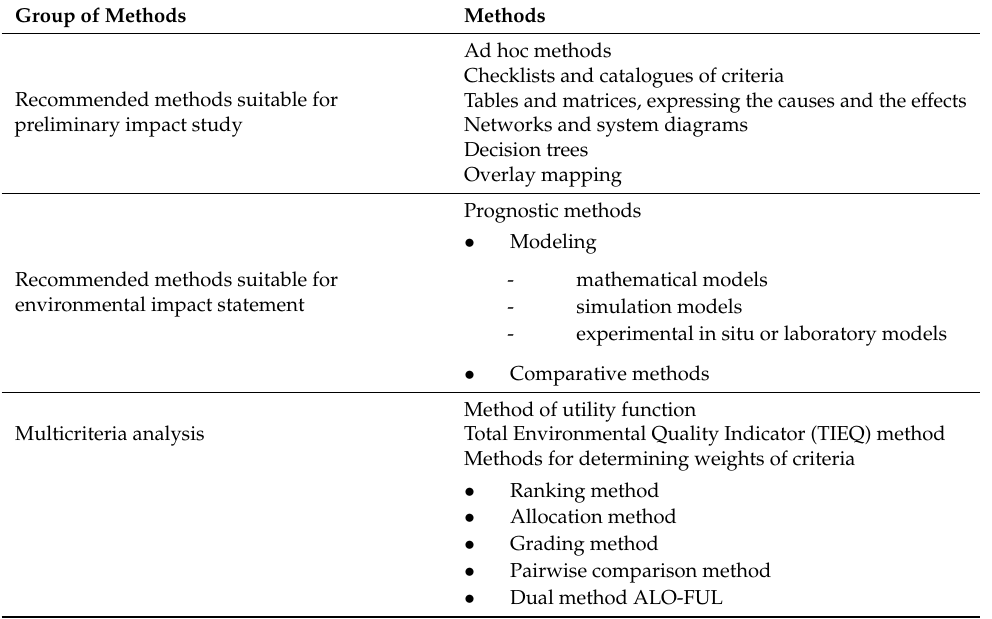
Table 1. Methods for impact assessment in the preliminary impact study, environmental impact statement and methods of multicriteria analysis (after Kozov á et al. 1996)